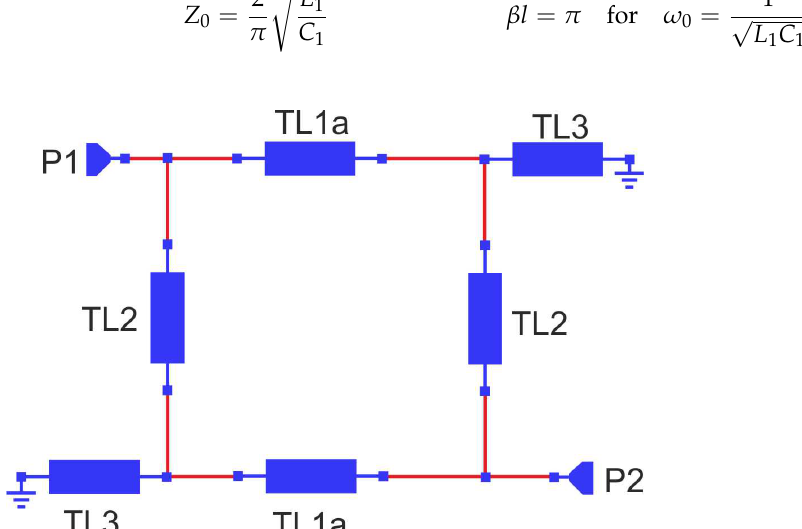
Figure 6. The full transmission line implementation of the lumped prototype filter is shown in Figure 1c.